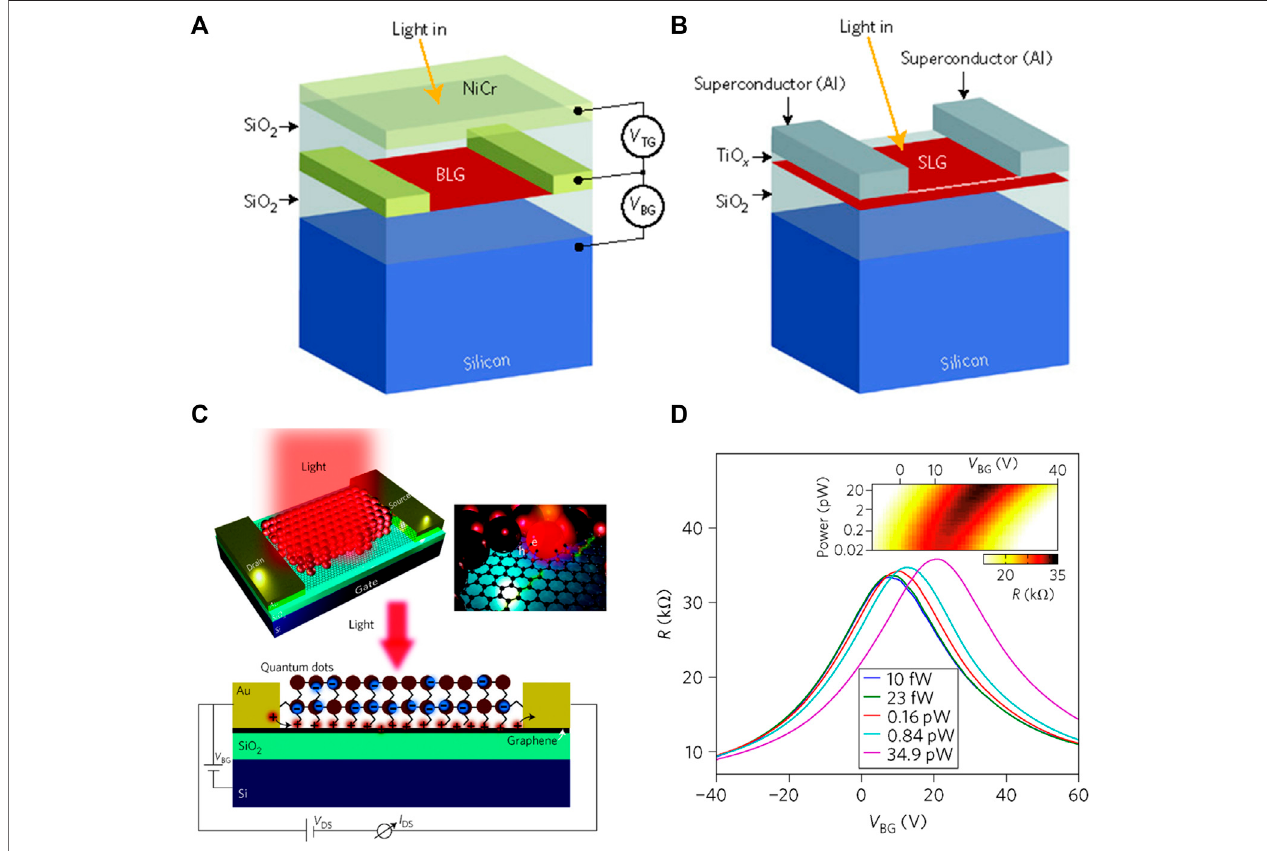
FIGURE 7 | (A) Graphene bi-layer bolometric device structure (Koppens et al., 2014), (B) Graphene – Al tunnel junction bolometer device structure (Koppens et al., 2014), (C) PhotodetectorsbasedonQDs(Konstantatosetal.,2012),and (D) Resistance – voltagerelationshipforthegraphene – QDstructure(Konstantatosetal.,2012); Reproduced with permission from (Konstantatos et al., 2012; Koppens et al.,